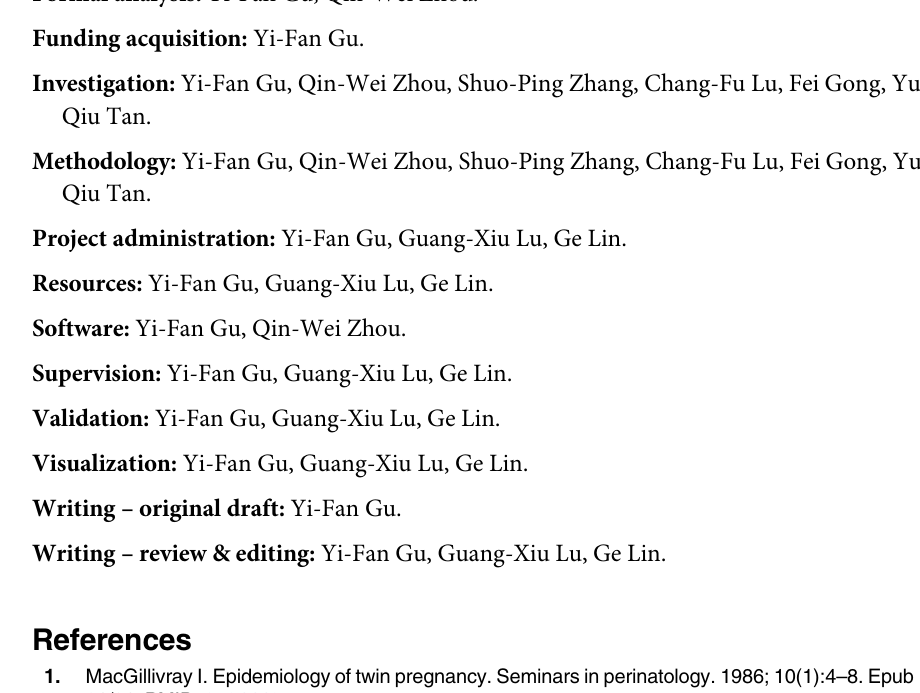
S1 Fig. Type I blastocysts. Figure 8-shaped blastocysts with ICM incarceration in which a part of TE cells were hatched out, but ICMs were trapped in the ZP opening (zona hole (cid:20) 30 μm); Bar = 30 μm. (TIFF) S2 Fig. Type II blastocysts. Partially hatched blastocysts without ICM incarceration in which ICMs were inside (A, B and C) or outside (D, E and F) of the ZP opening, or the blastocysts hatched with a U-shape (zona hole expanded > 30 μm) (G, H and I); Bar = 30 μm. (TIFF) S3 Fig. Type III blastocysts. Fully hatched blastocysts in which all TE and ICM cells were hatched out of zone; Bar = 30